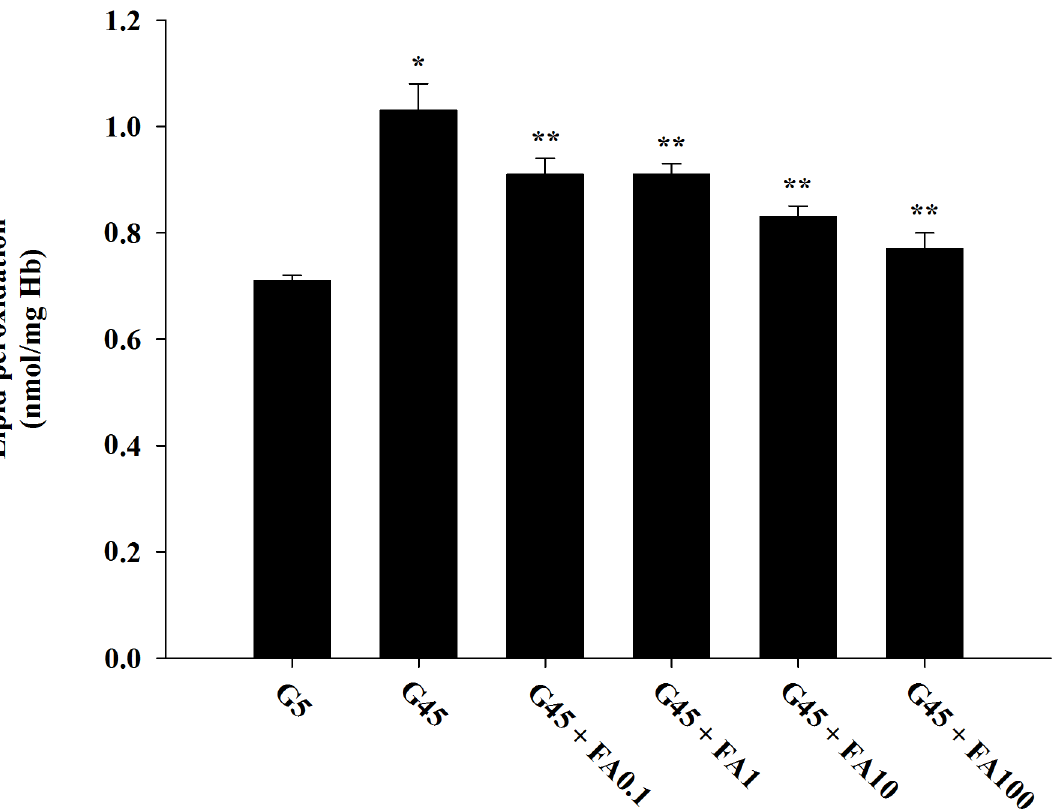
Fig 4. The effects of ferulic acid (0.1 – 100 μ M) on lipid peroxidation in erythrocytes treated with 45 mM glucose. The results are expressed as mean ± SEM ( n = 6). * p < 0.05 compared to 5 mM glucose (G5) and ** p < 0.05 compared to 45 mM glucose (G45) treatments.).